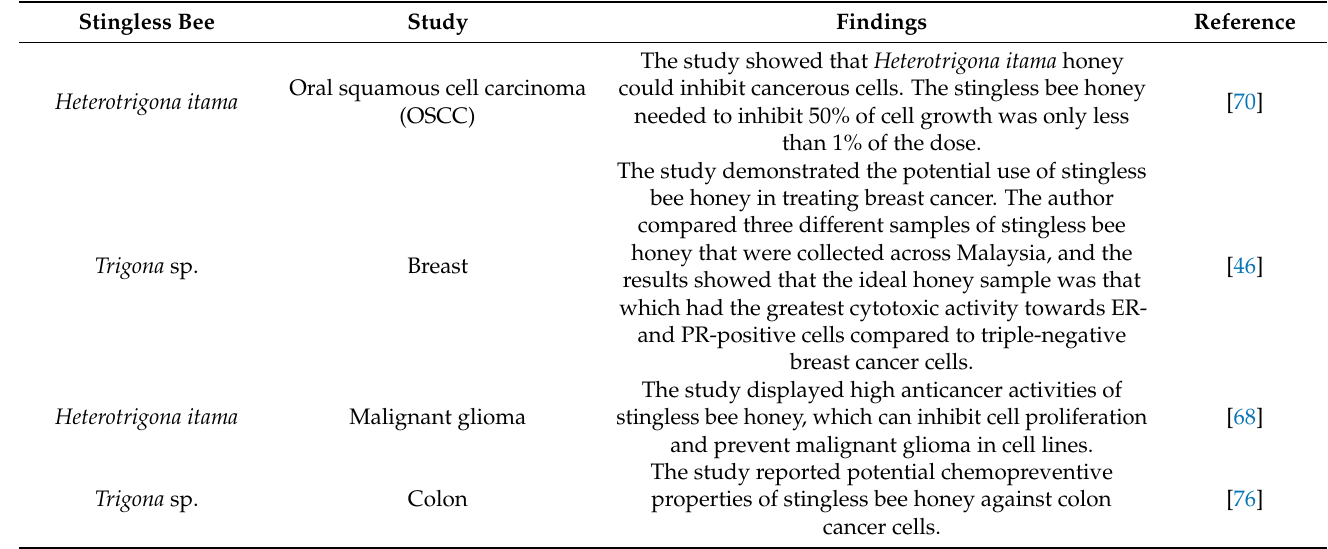
Table 4. Anticancer potential of stingless bee